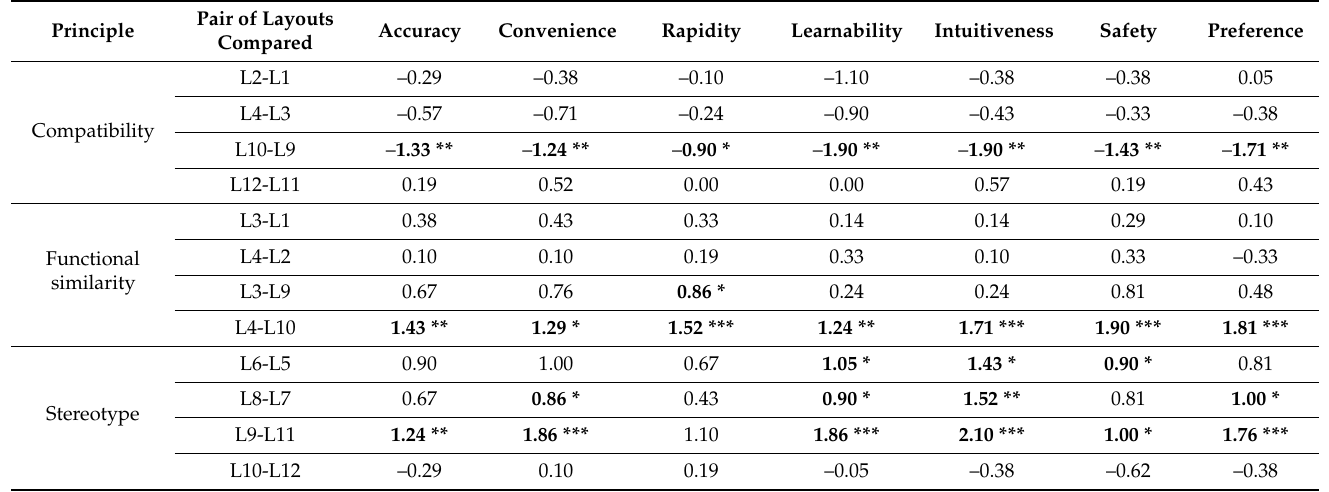
Table 6. Mean differences between layouts to which ergonomic principles were applied and layouts to which they were not